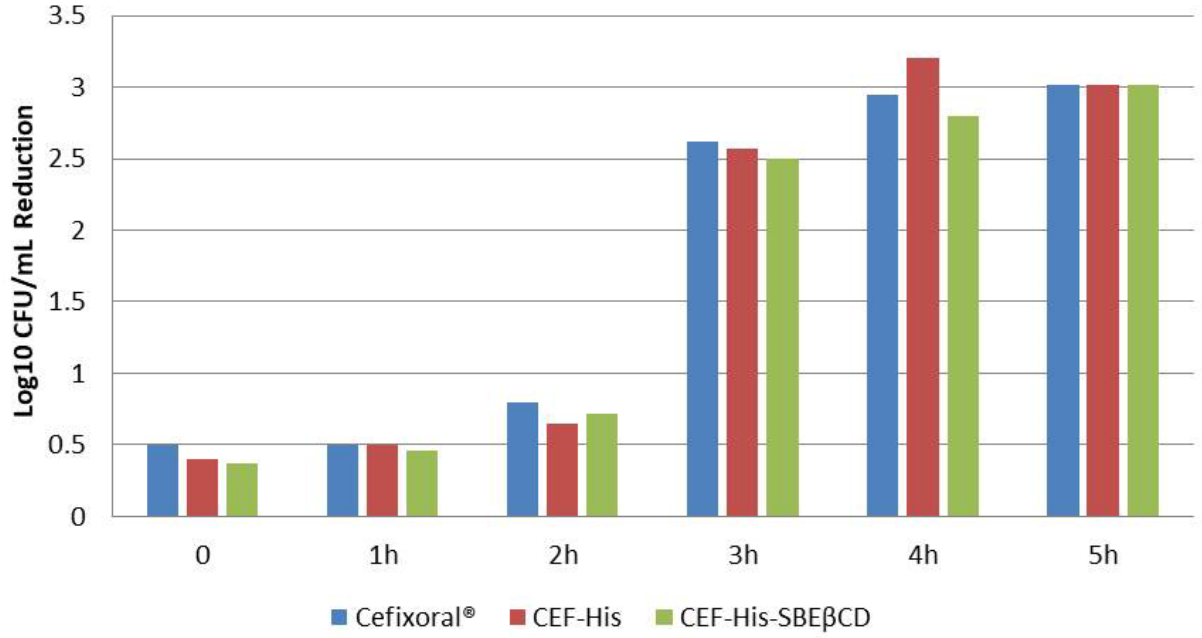
Figure 8. Time kill assay for the evaluation of antimicrobial effectiveness of Cefixoral ® suspension, and CEF-His 1:2 mol/mol and, CEF-His-SBE β CD 1:2:1 mol/mol solutions against E. coli expressed as Log 10 CFU/mL reduction at different times.